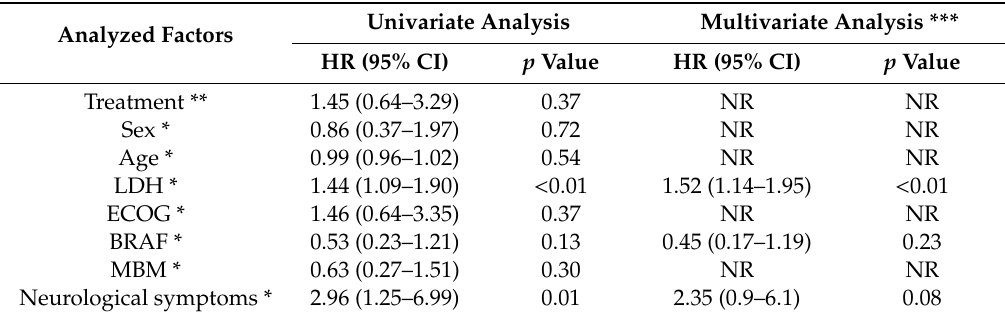
Table 2. Univariate and multivariate analysis: factors associated with overall survival after diagnosis of leptomeningeal